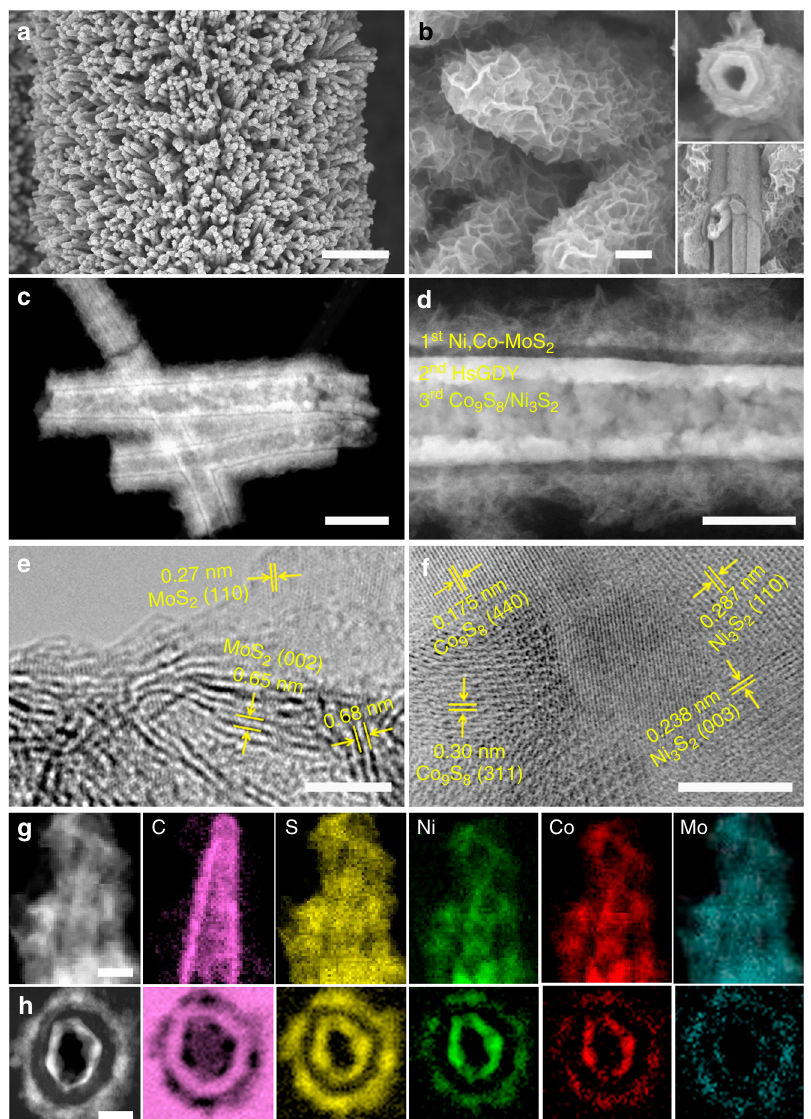
Fig. 4 Micrographs of the tri-layered nanoarrays. a , b scanning electron microscopy (SEM) images, c , d high angle annular dark fi eld-scanning transmission electron microscopy (HAADF-STEM) images, e , f high-resolution transmission electron microscopy (HRTEM) images, g side-view, and h microtome- prepared cross-section scanning transmission electron microscopy-energy loss spectroscopy (STEM-EELS) elemental mappings of the hierarchical triple- layered NiCoS@HsGDY@Ni,Co-MoS 2 nanotubular arrays comprised of Ni 3 S 2 /Co 9 S 8 inner layer (NiCoS), hydrogen-substituted graphdiyne (HsGDY), and Ni-,Co-co-doped MoS 2 (Ni,Co-MoS 2 ). The insets of b show some broken areas; e and f are collected at the external Ni,Co-MoS 2 nanosheets and the interior NiCoS nanotubes, respectively. Scale bars: a 2 μ m, b , d 100 nm, c 200 nm, e , f 5 nm, g 50 nm, h 20